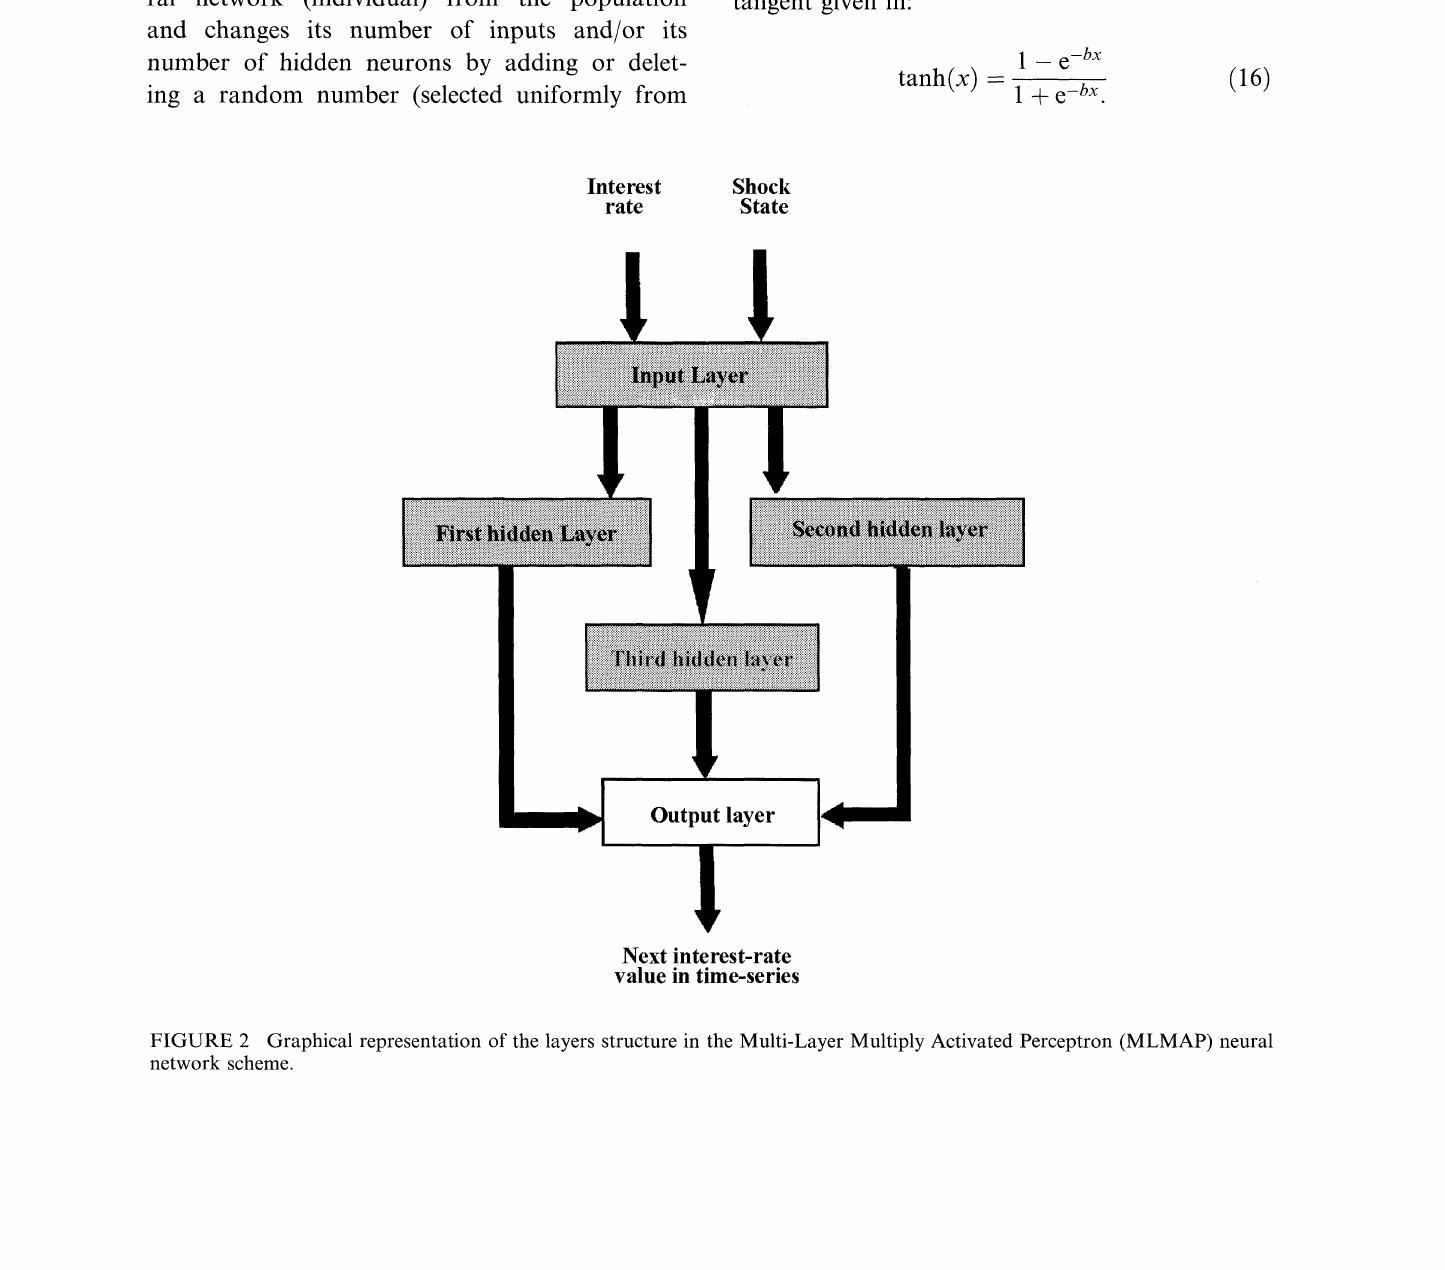
FIGURE 2 Graphical representation of the layers structure in the Multi-Layer Multiply Activated Perceptron (MLMAP) neural network